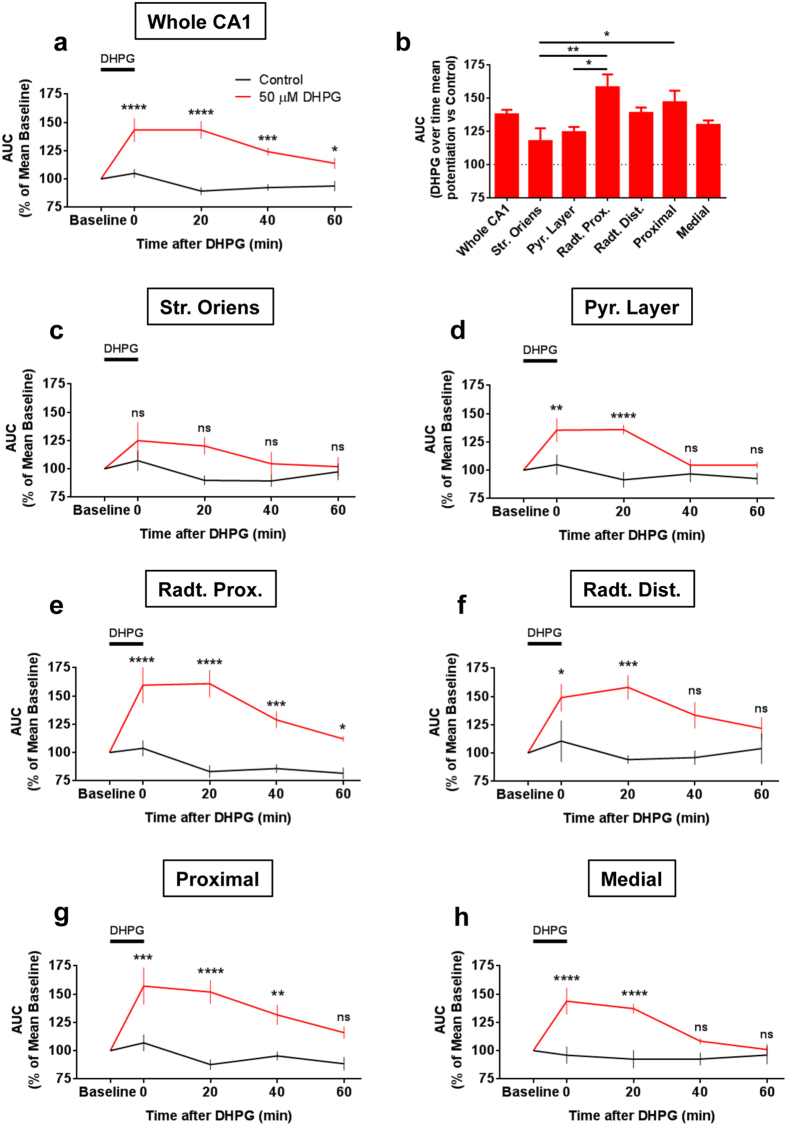
Long-lasting increase of VSDI-recorded fIPSPs after group-I mGlu receptors activation.Application of the selective group-I mGlu receptors agonist (S)-3,5-Dihydroxyphenylglycine (DHPG) for 10 minutes induces long-lasting enhancement of fIPSPs during washout of the drug in the whole CA1 (a) and in its different sub-regions (c–h). (b) Graph showing mean over time percentage potentiation of DHPG vs control in whole CA1 and in its different sub-fields; one-way ANOVA followed by Tukey post-hoc test. n = (slices, mice): DHPG group = (7, 5), Control group = (7, 4). Data are mean ± s.e.m. Statistical analysis in (a) and (c–h) is two-way ANOVA followed by Bonferroni post-hoc test. *p < 0.05, **p < 0.01, ***p < 0.001, ****p < 0.0001, ns = not significant.